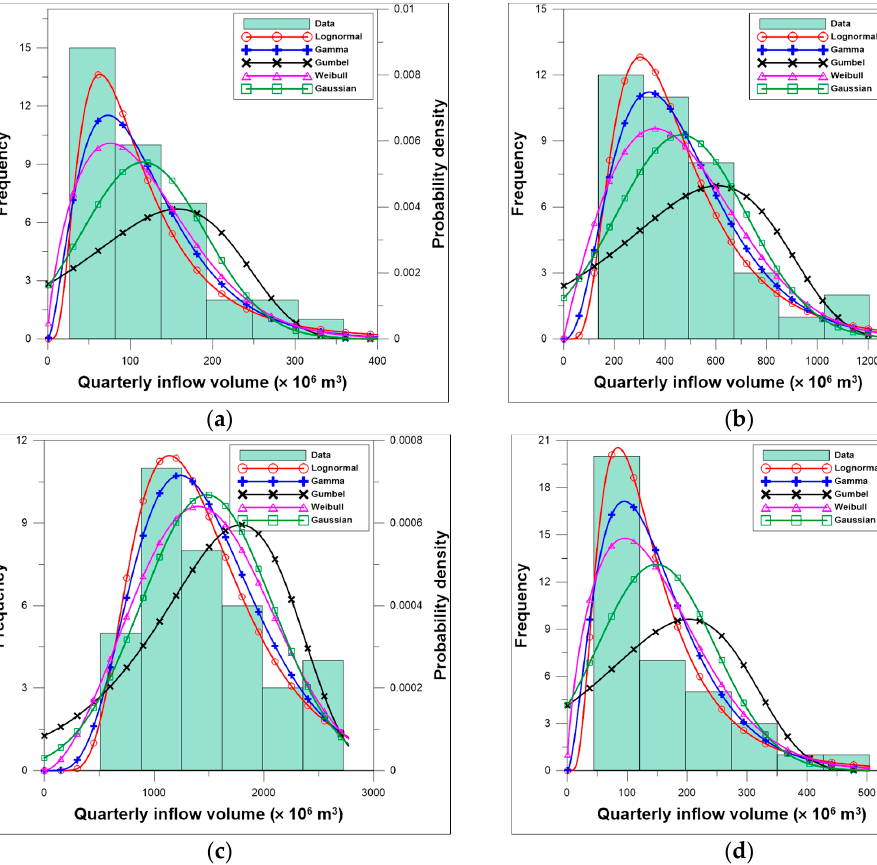
Figure 7. Histogram against the five distributions of the quarterly inflow volumes of the Soyanggang dam during the training period of 1974–2010: ( a ) first quarter; ( b ) second quarter; ( c ) third quarter; ( d ) fourth quarter.